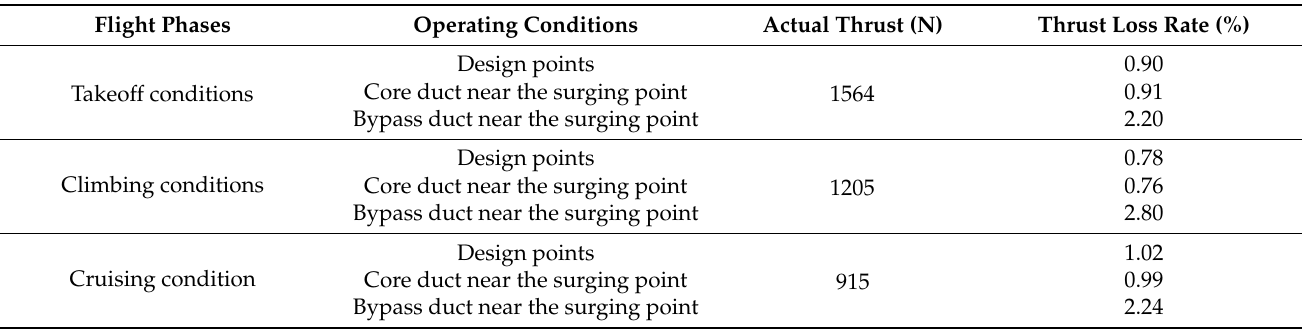
Table 2. Engine thrust loss at different working